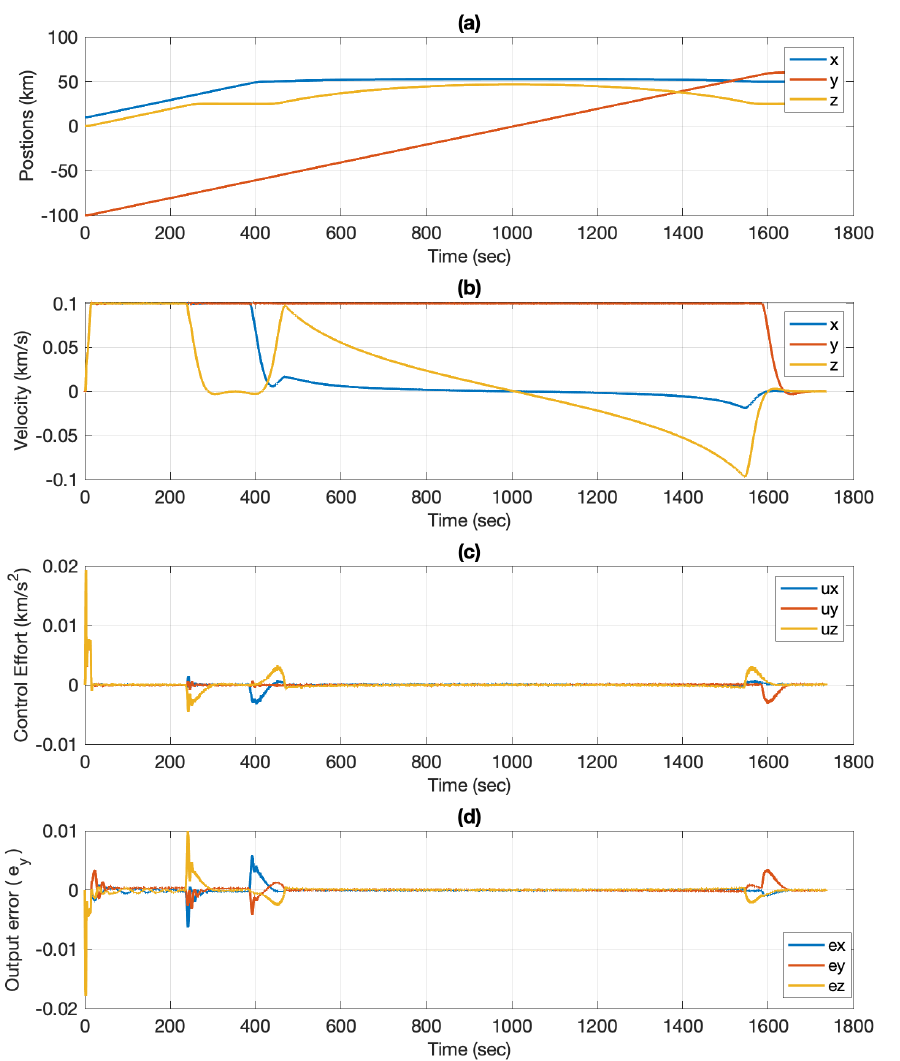
Figure 12. Plots for adaptive control case with noise for asteroid Kleopatra: ( a ) position vs. time; ( b ) velocity vs. time; ( c ) control effort vs. time; ( d ) output error vs.